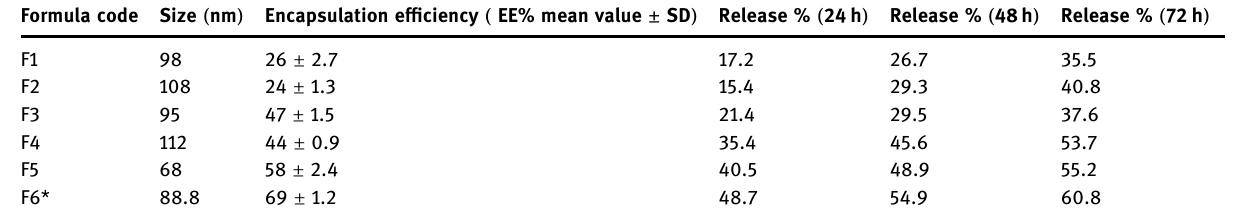
Table 4: Size, EE%, and extract release rate at 24, 48, and 72 h for Nio - GGE